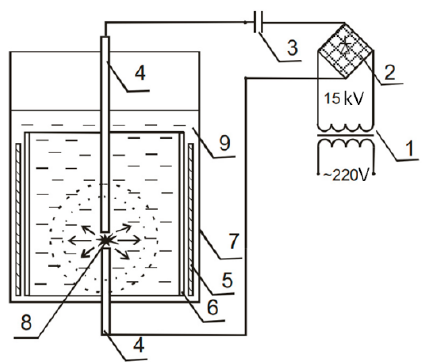
Figure 1. A schematic diagram of the discharge–pulse treatment of the liquid. 1—step-up transformer; 2—diode bridge; 3—capacitor; 4—electrodes; 5—treated fabric; 6—cylindrical mesh; 7—reactor vessel; 8—discharge zone; 9—liquid.